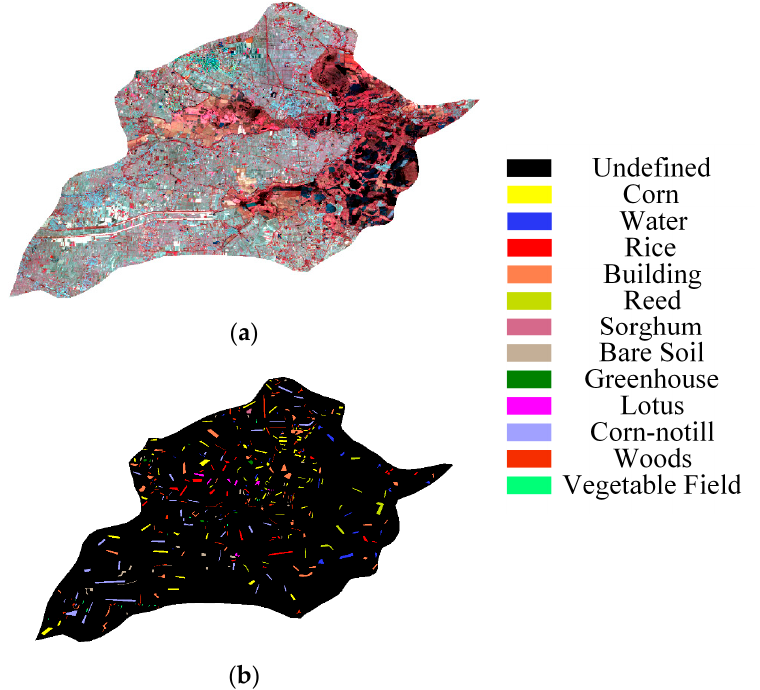
Figure 7. GF-5 dataset of Anxin County, Xiongan New Area: ( a ) false-color composite of GF-5, ( b ) ground-truth map.